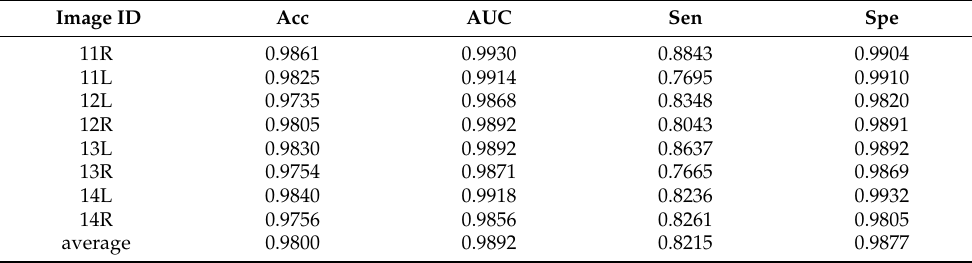
Table 6. The performance for each case of the CHASEDB1 dataset inside FOV.